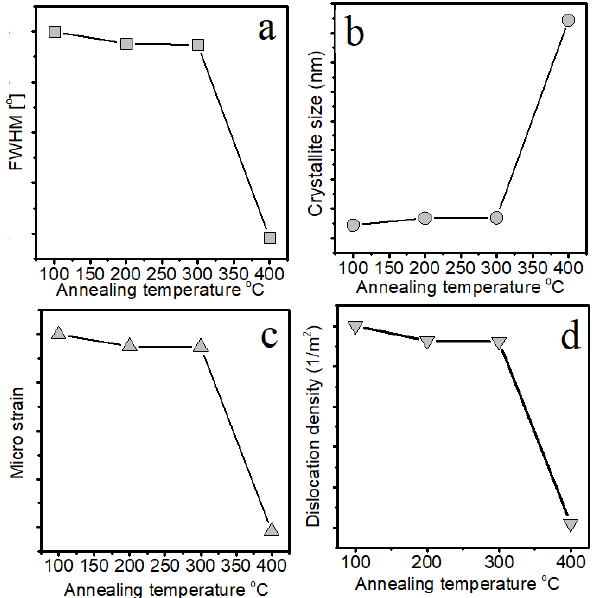
Figure 2: (a) Crystallite size, (b) Full width at half maximum, (c) Dis- location density and (d) Microstrain of titanium oxide as a function of annealing temperature at the dominate reflection